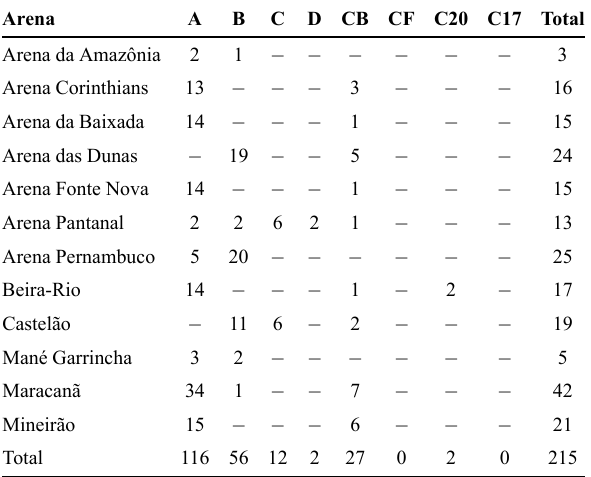
Table 2 - Arena usage in the 2014 season. Arena A